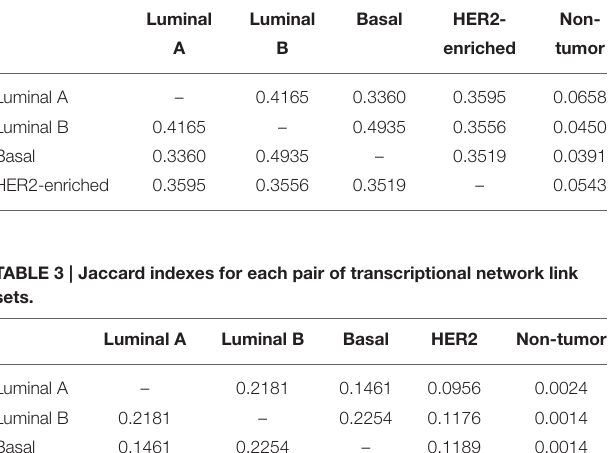
enriched tumor 0.0658